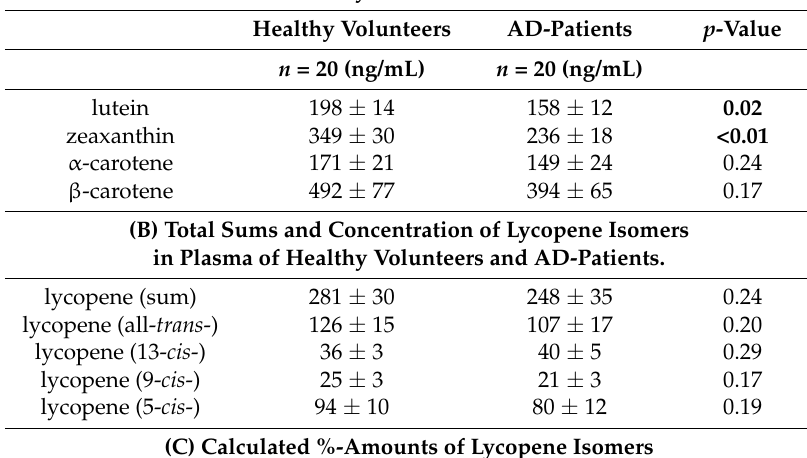
Table 2. Carotenoid concentrations ( A ), total sum and individual concentrations of lycopene isomers ( B ), calculated %-amounts of individual lycopene-isomers from the sum of lycopene isomers ( C ) and calculated ratios of selected lycopene isomers all calculated based on determined plasma concentrations from healthy volunteers and